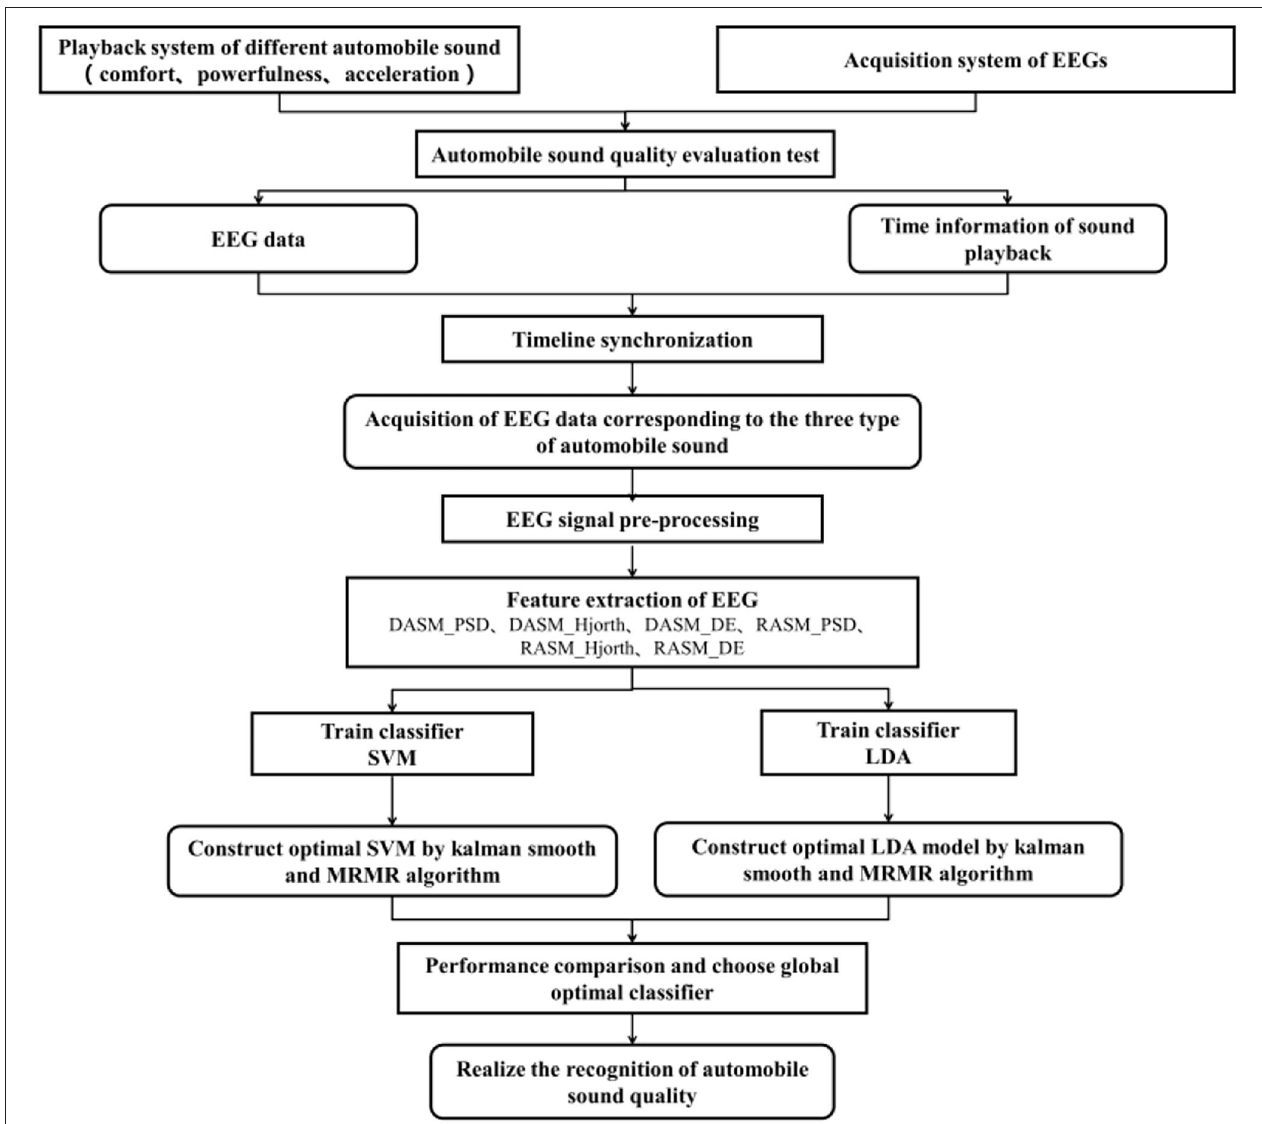
FIGURE 1 | Flow chart for the new evaluation method of car sound quality based on brain